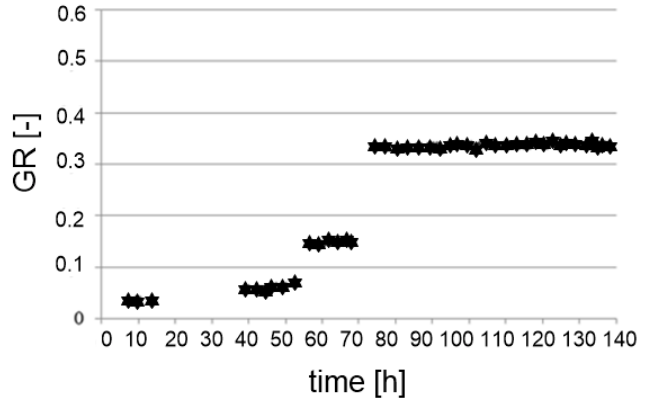
Figure 10. Gradient ratio versus time (adapted from [54]).